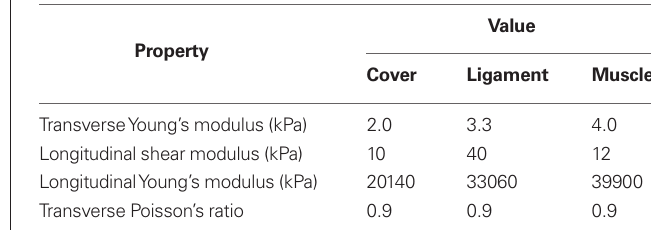
Table 1 | Material properties for three layers of the vocal fold model based on Alipour et al. (2000) and Cook et al. (2008)